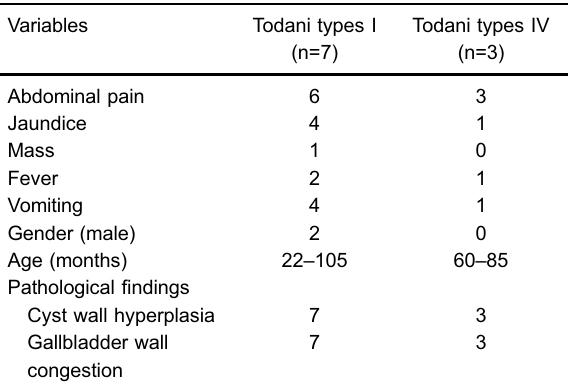
Table 2. Demographic and clinical characteristics of pediatric pancreaticobiliary